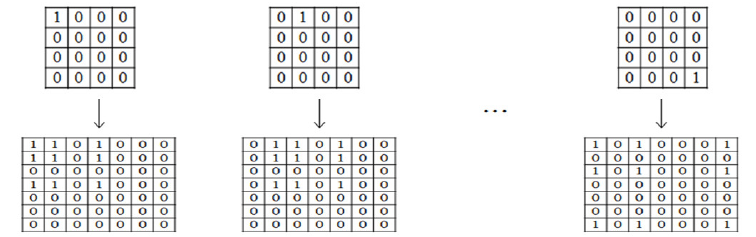
Figure 5. 16 chosen code arrays of the (49, 16) product code.